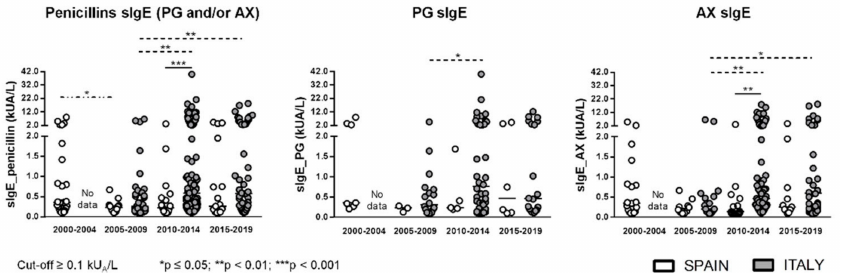
Figure 2. sIgE levels (kUA/L) to PG and/or AX, to PG, or to AX in both Spanish and Italian patients with positive ImmunoCAP ® . Significant differences if p ≤ 0.05.